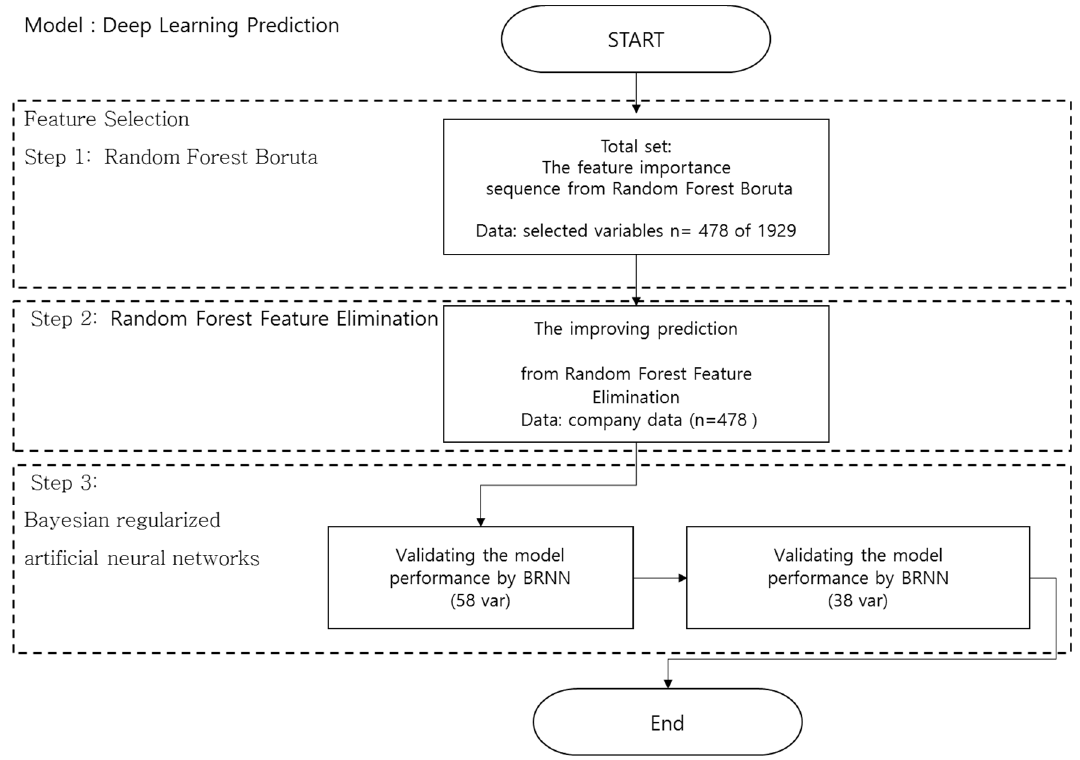
Figure 1. Analytic Algorithm Methodology: Deep Learning Prediction and Regression Prediction Algorithms.